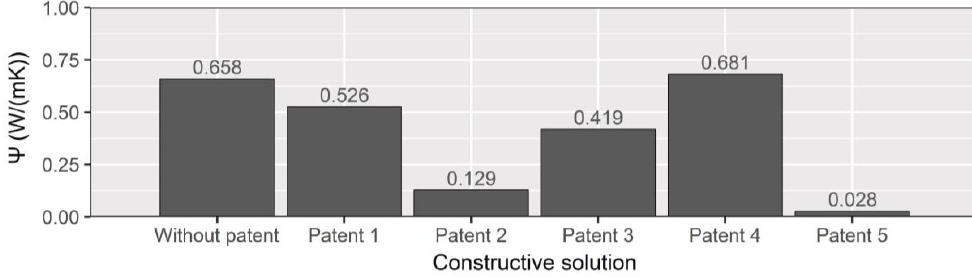
Figure 7. Results of linear thermal transmittance obtained for each constructive solution analysed.